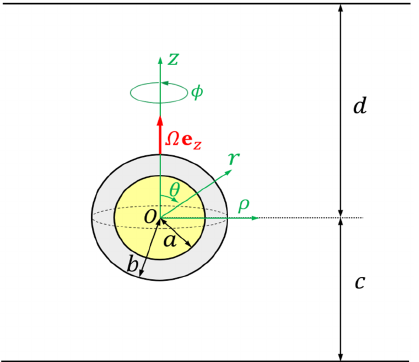
Figure 1. Geometrical sketch of a soft spherical particle rotating about a diameter normal to two planar walls.